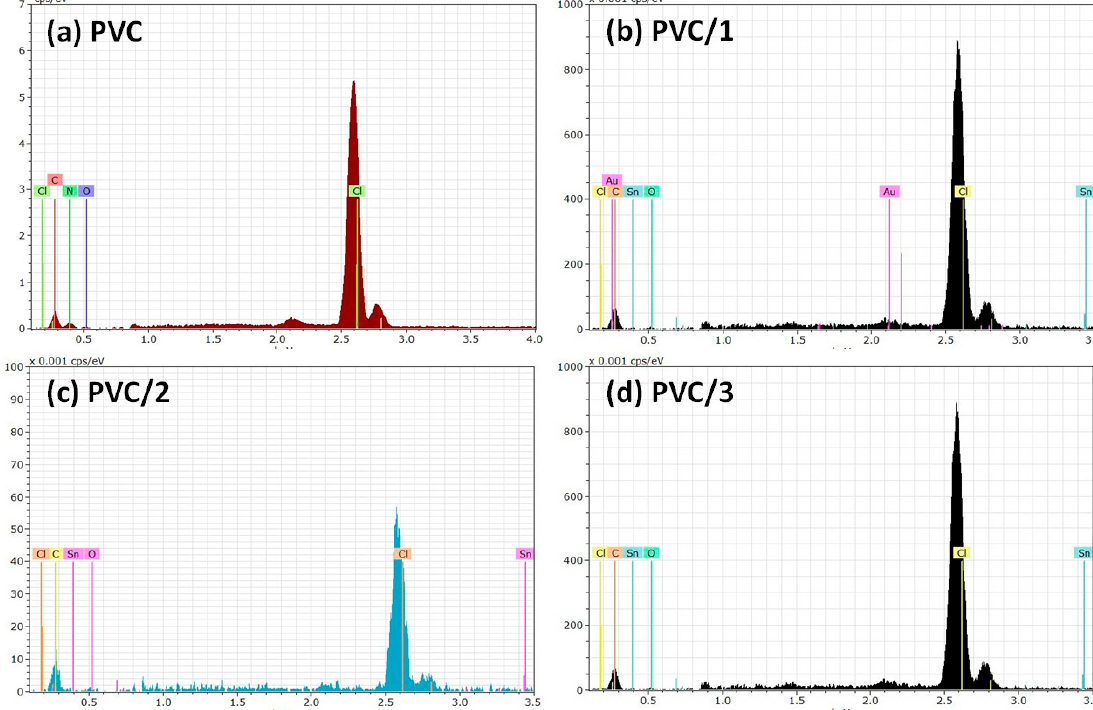
Figure 3 . Energy-dispersive X-ray spectroscopy (EDX) spectra of the ( a ) blank poly(vinyl chloride) (PVC) film and the PVC films containing 0.5 wt% ( b ) complex 1 , ( c ) complex 2 , and ( d ) complex 3 . (PVC) film and the PVC films containing 0.5 wt % ( b ) complex 1 , ( c ) complex 2 , and ( d ) complex 3